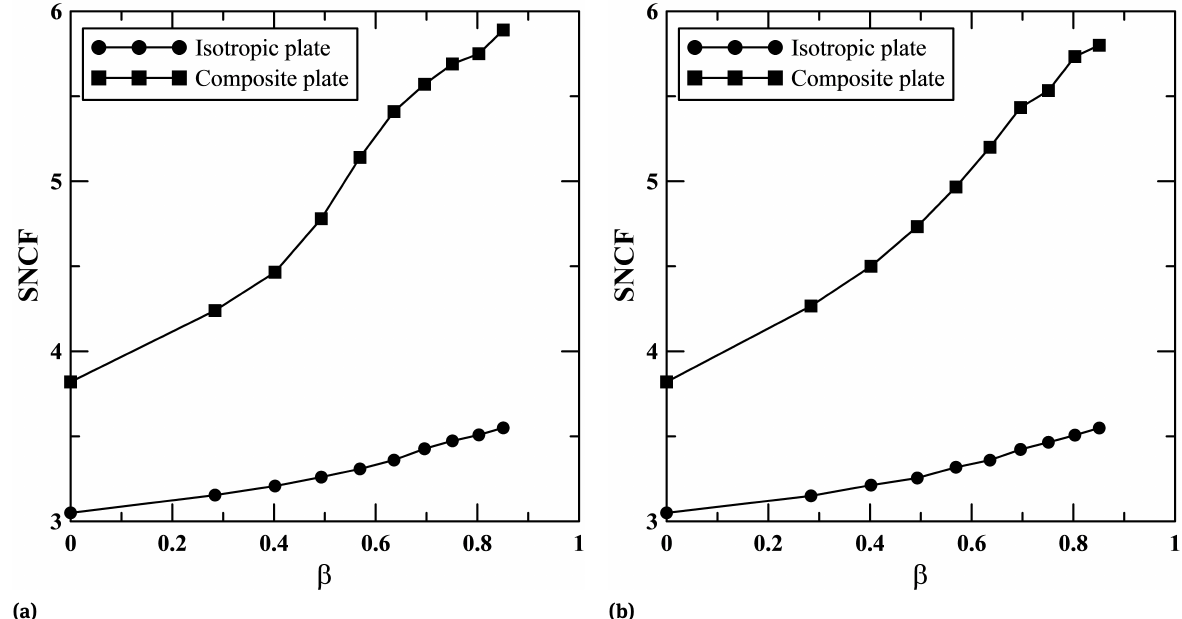
Figure 16: Effect of plate curvature on: (a) stress concentration factor and (b) strain concentration factor